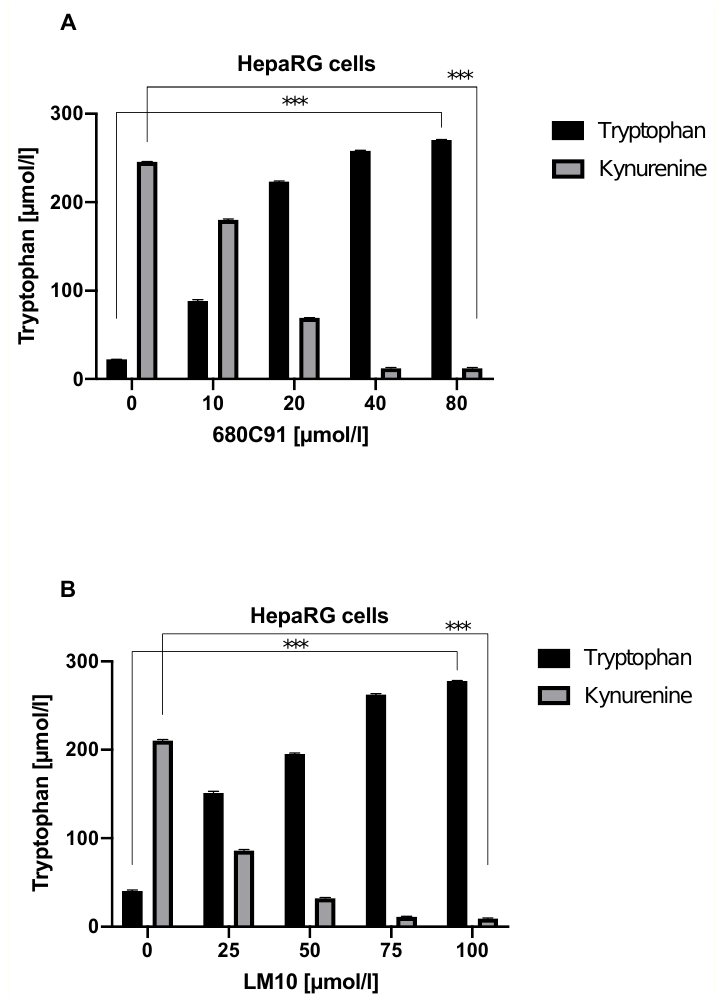
Figure 5. The effect of TDO inhibition with 680C91 ( A ) and LM10 ( B ) on Trp degradation in HepaRG cells. *** p < 0.001.